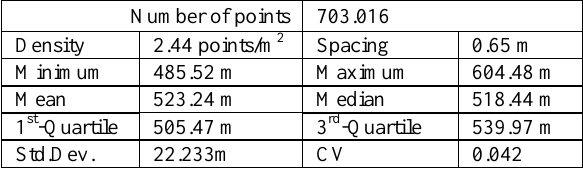
Table 1. Experimental test dataset characteristics.